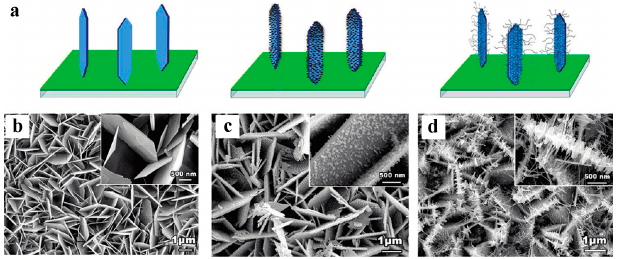
Figure 2. ( a ) The schematic process of the hierarchical ZnO nanoarchitectures and ( b – d ) SEM images of the hierarchical ZnO nanowire-nanosheet architectures at different stages (Reproduced with permission from [32], Copyright 2010, American Chemical Society).